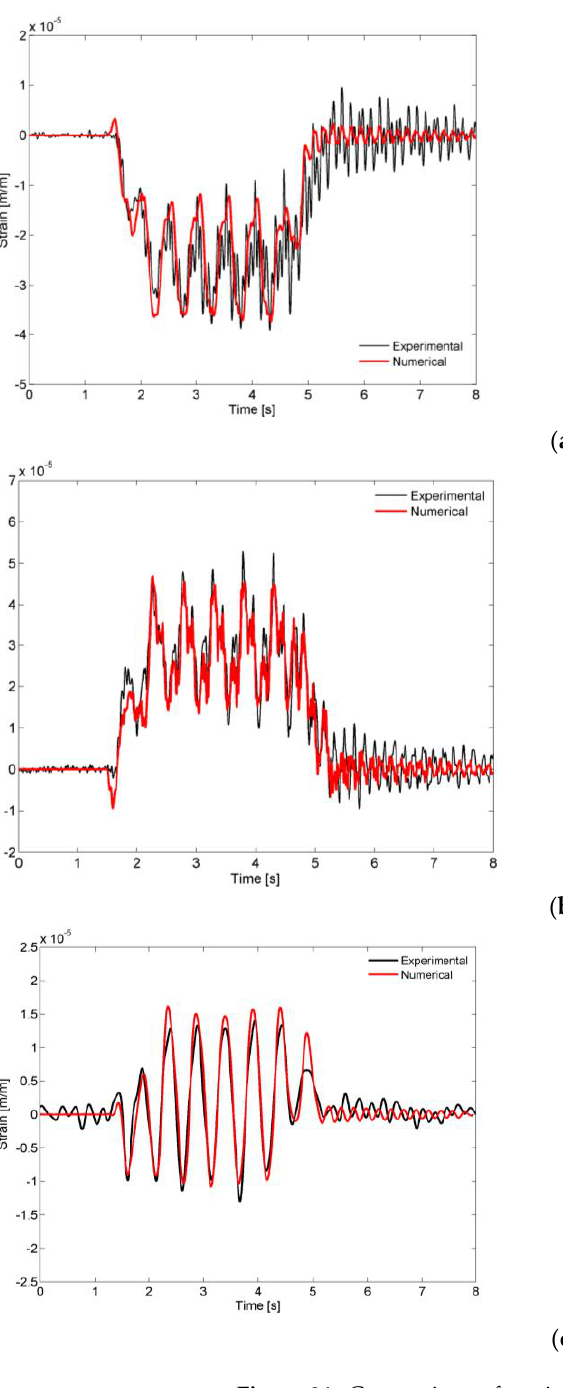
Figure 21. Comparison of strains records and respective auto-spectra for the passage of the Alfa Pendular train at a speed of 180 km/h, obtained experimentally and numerically, from locations ( a ) S5, ( b ) S1, and ( c ) S4.